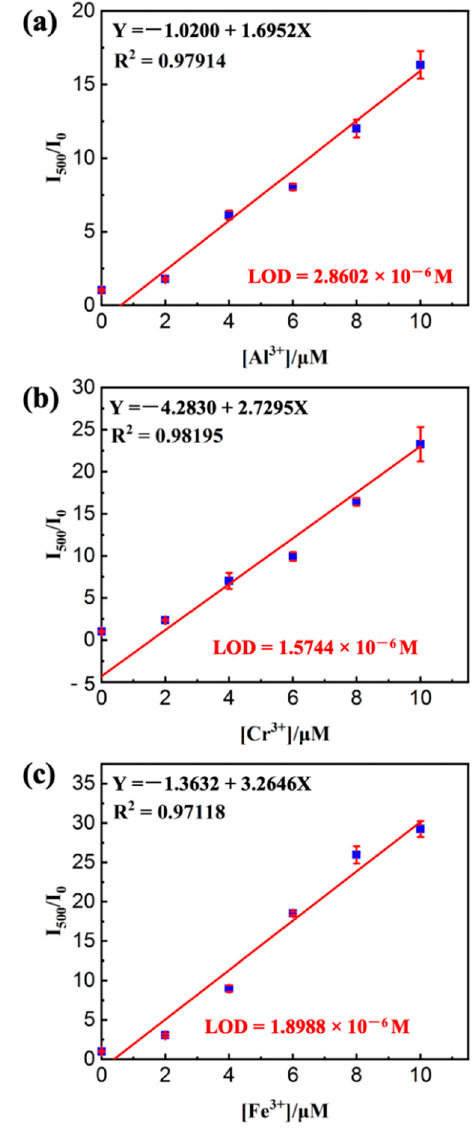
Figure 9. Standard deviation and linear fitting calculations for detection limits of ( a ) PE/MNPs microcapsules—Al 3+ ( b ) PE/MNPs microcapsules—Cr 3+ and ( c ) PE/MNPs microcapsules—Fe 3+ based on PL intensity changes at 500 nm. Table 1. Comparison of previous reported pyrene-based derivative sensors for metal ions detection.